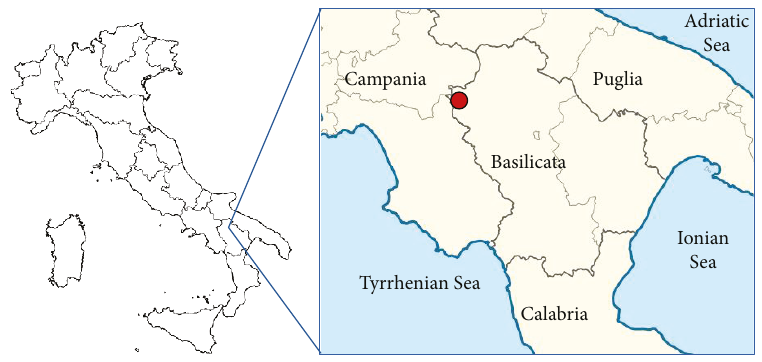
Figure 1: Localization of the investigation